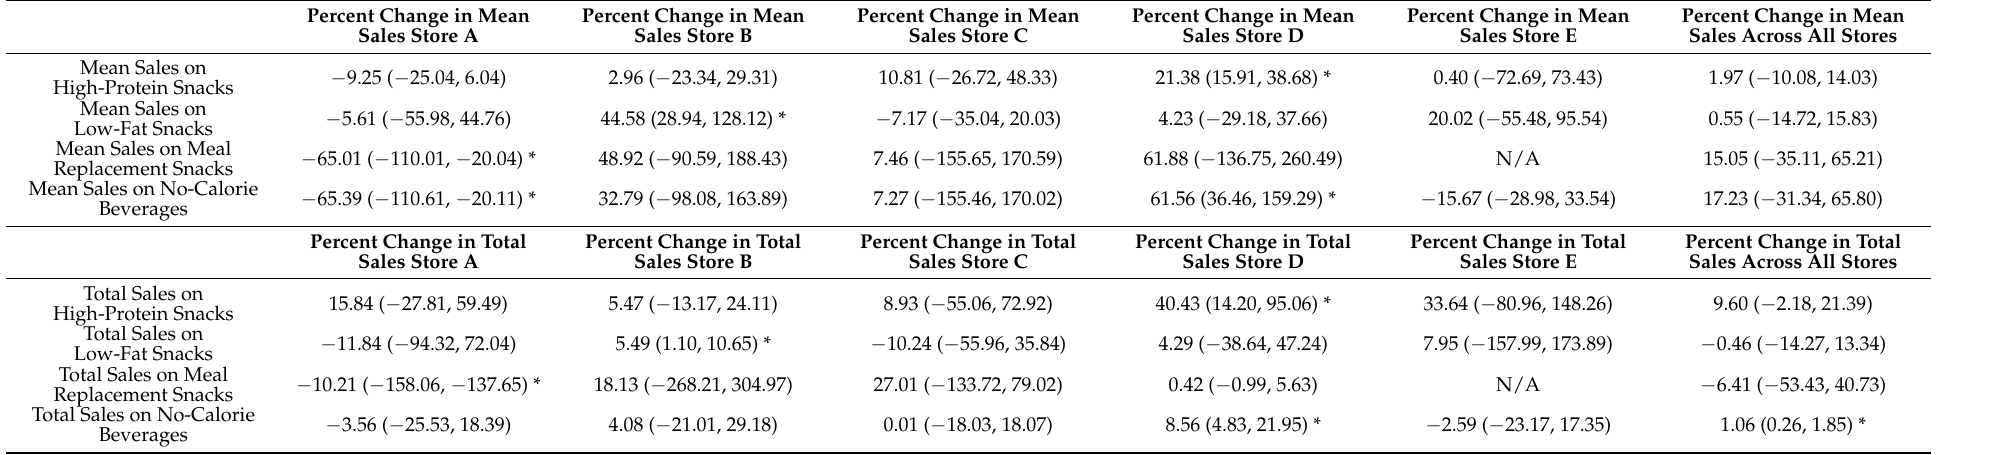
Table 2. Percent change in mean and total sales over time within and between